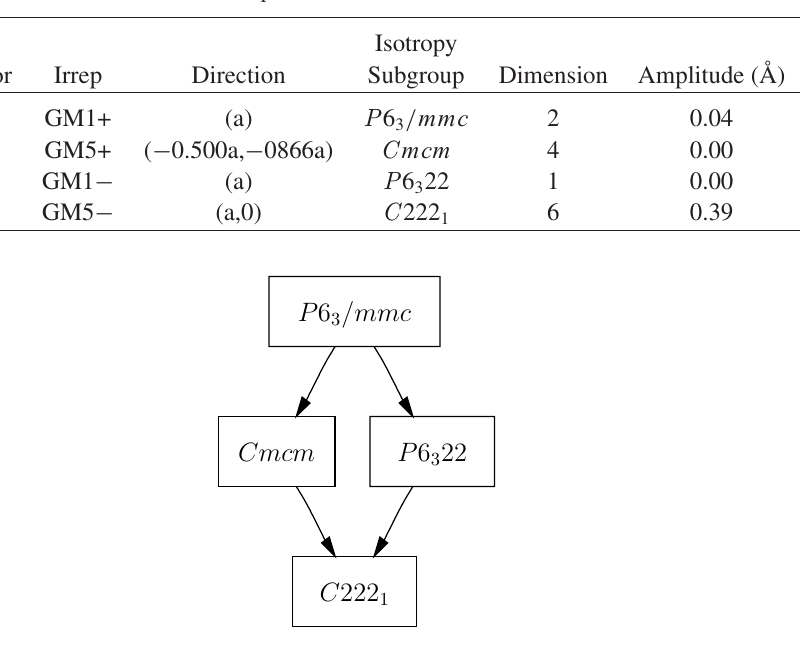
Table 7. Summary of the symmetry-mode decomposition of the C 222 1 structure of SrMnO 3 reported in [21] with respect to the P 6 3 /mmc structure at 350K. The table indicates the amplitudes in Å of the different irrep distortions allowed by symmetry, indicating for each irrep, its wave vector, label, direction within the irrep space, isotropy subgroup and dimension of the distortion subspace.